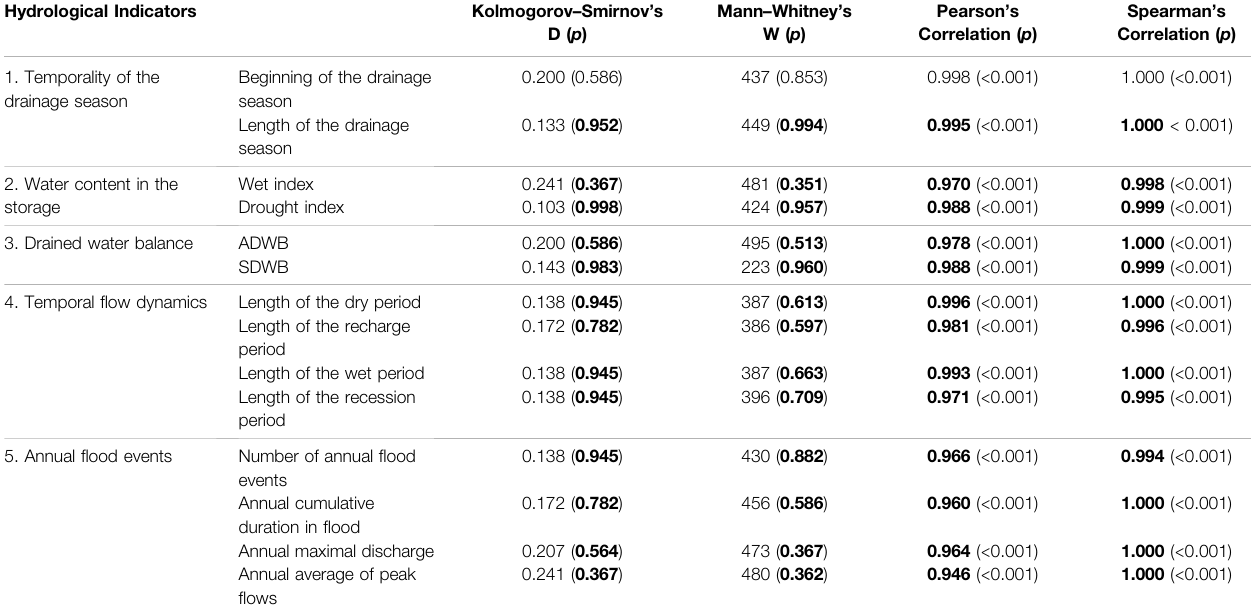
TABLE 4 | Results of the signi fi cant tests and the correlation tests comparing the HI CP_HIST and HI REF distribution functions in the historical period (1975 – 2004). Hydrological